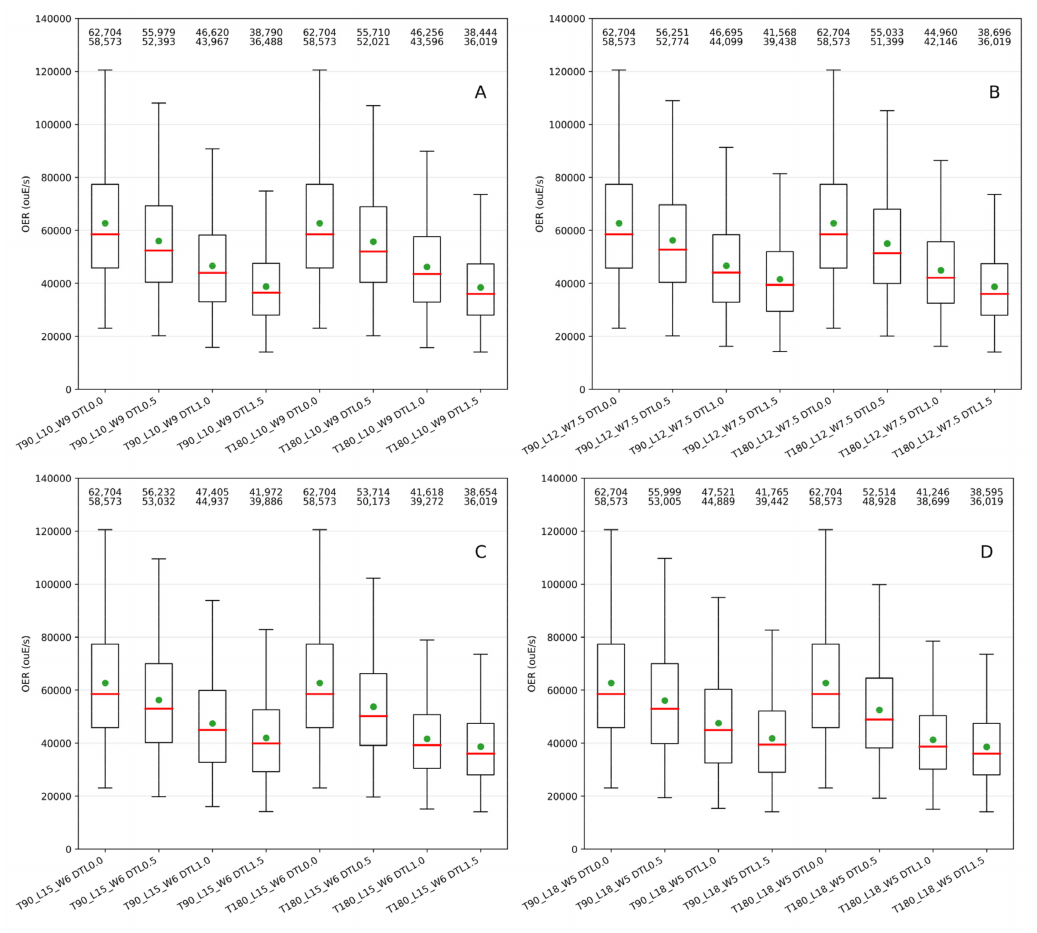
Figure 9. Box and whiskers plot of the OERs (ouE/s) for the different tanks and scenarios. The green circle represents the mean value, while the red segment represents the median value. The mean and median values are also numerically reported in the upper part of the figure. ( A ): tank L10_W9, shape factor 1.11. ( B ): tank L12_W7.5, shape factor 1.60. ( C ): tank L15_W6, shape factor 2.50. ( D ): tank L18_W5, shape factor